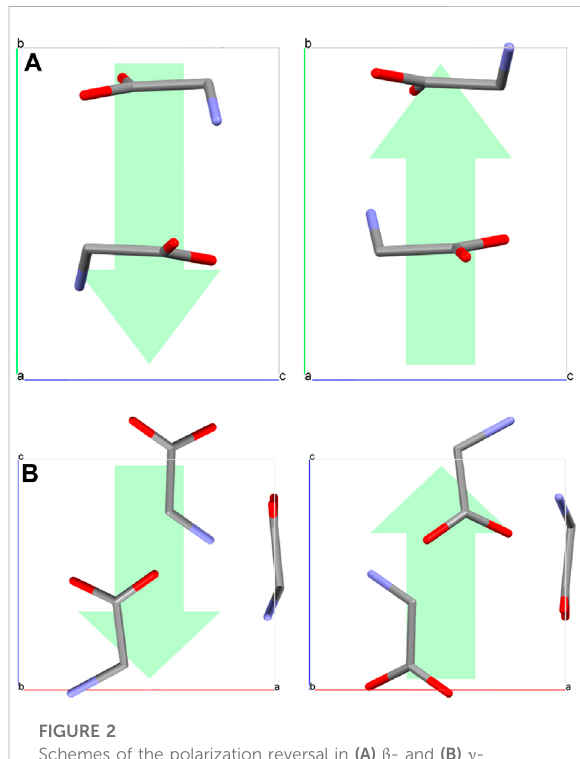
FIGURE 2 Schemes of the polarization reversal in (A) β - and (B) γ - glycine. Green arrows show the direction of the spontaneous polarization.Molecularcolorscheme:carbon — grey,oxygen — red, nitrogen — blue. Hydrogen atoms are not shown for